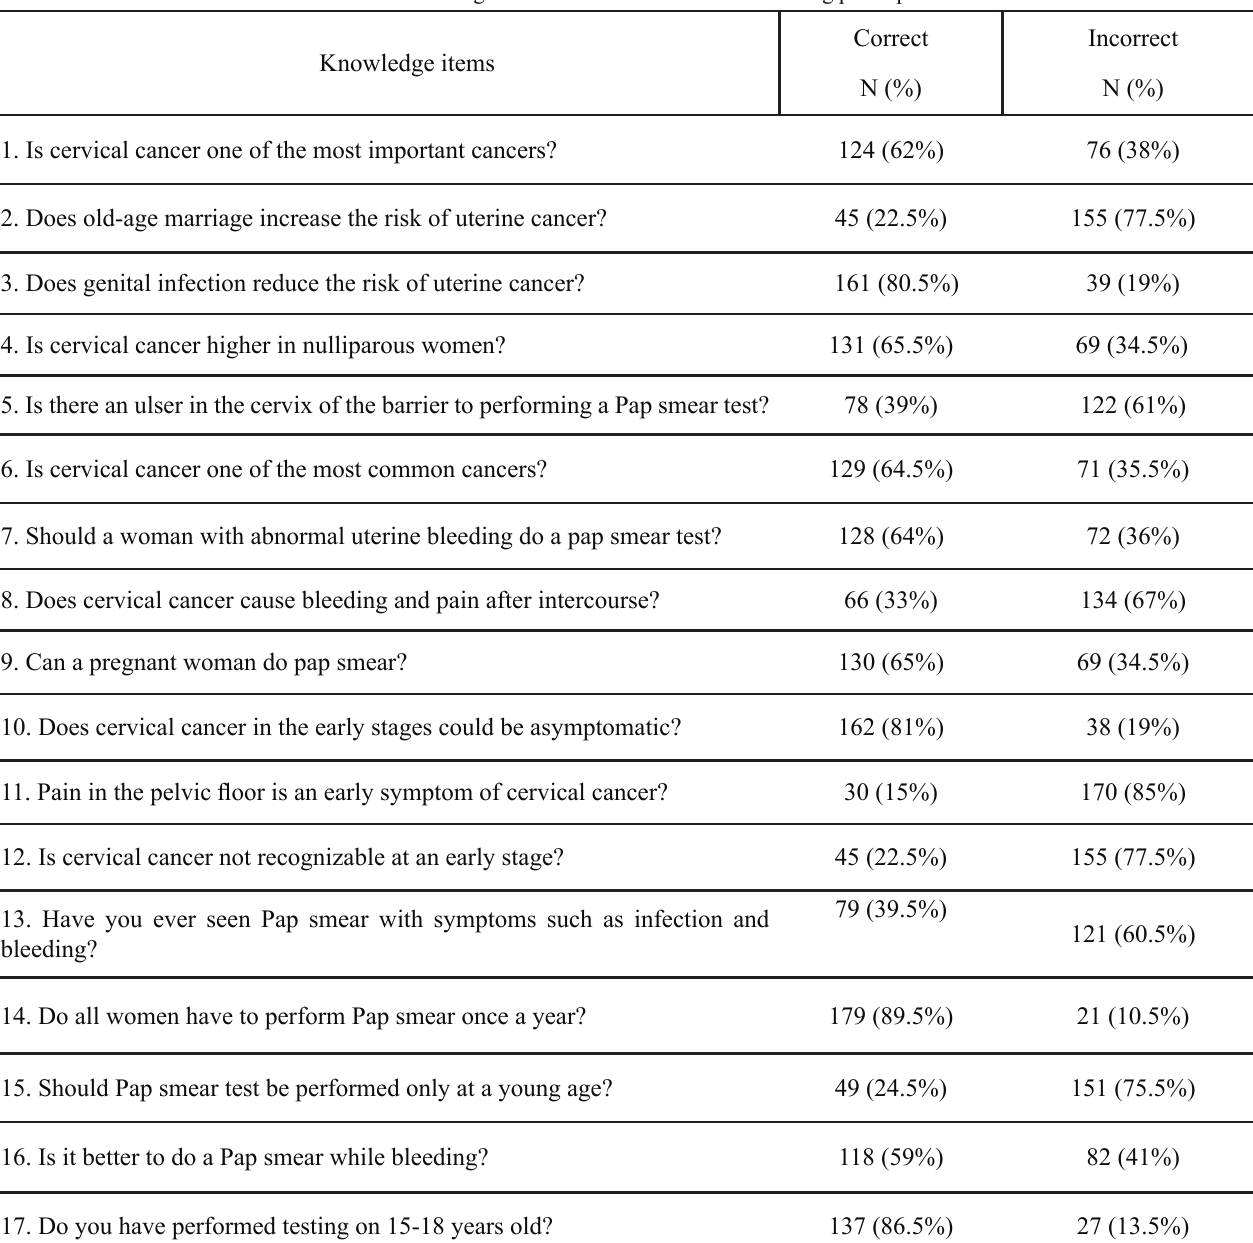
Table 1. Knowledge of cervical cancer risk factors among participants Knowledge